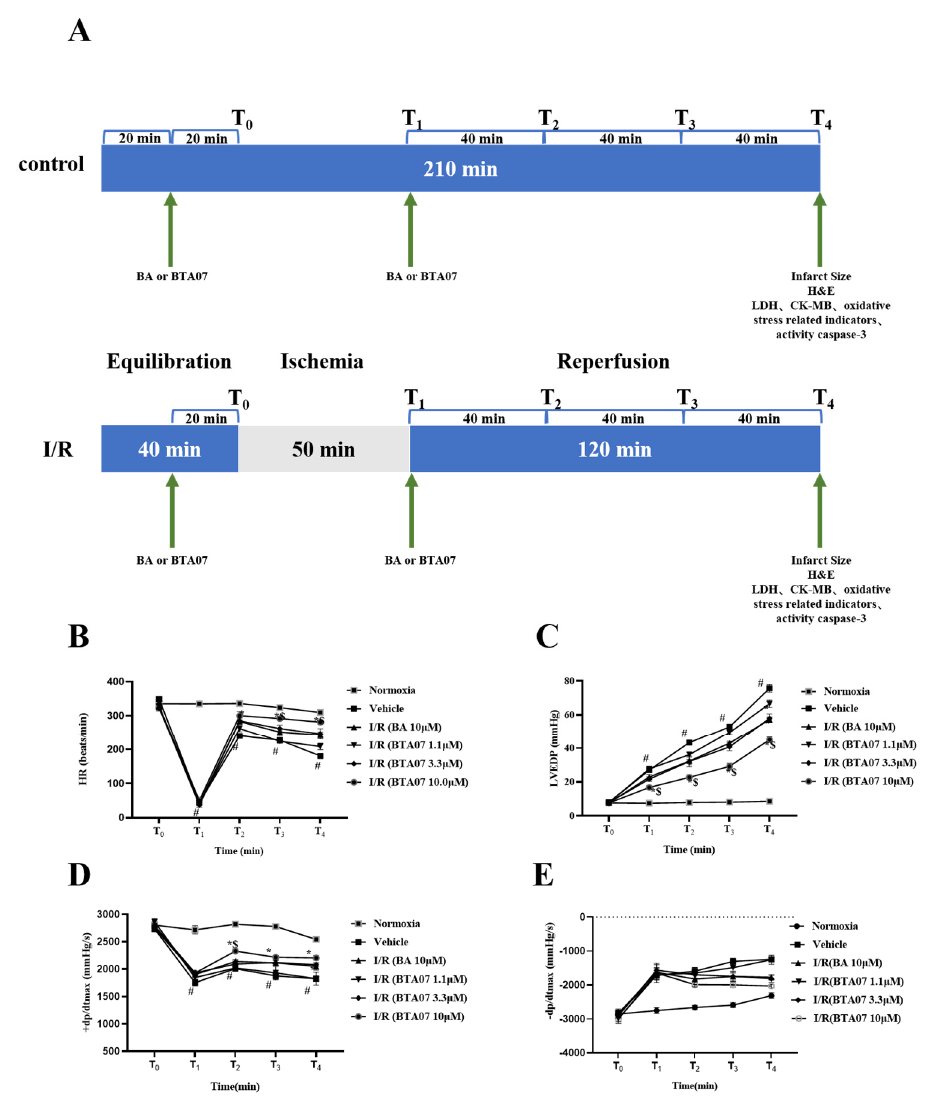
Figure 2. BTA07 treatment improved the hemodynamic parameters of isolated rat hearts. ( A ) Animal grouping and timeline ex vivo. Heart rate (HR, ( B )) left ventricular end diastolic pressure (LVEDP, ( C )), maximum rate of risen left ventricular pressure (+dP/dt max, ( D )) and maximum rate of fallen ventricular pressure ( − dP/dt max, ( E )) in the isolated rat heart preparation were monitored and recorded by Lab Chart. Data were presented as means ± S.E.M for five independent experiments. # p < 0.05 vs. normoxia group; * p < 0.05 vs. vehicle group; $ p < 0.05 vs. BA group; two–way ANOVA test, followed by a Student − Newman − Keuls test.